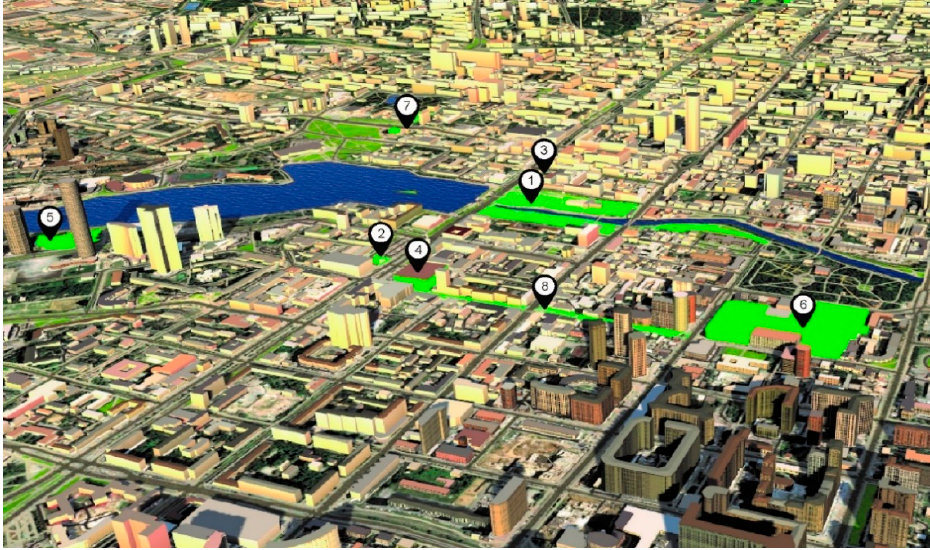
Figure 2. Visual model of Yekaterinburg with indication of places and spaces where young people